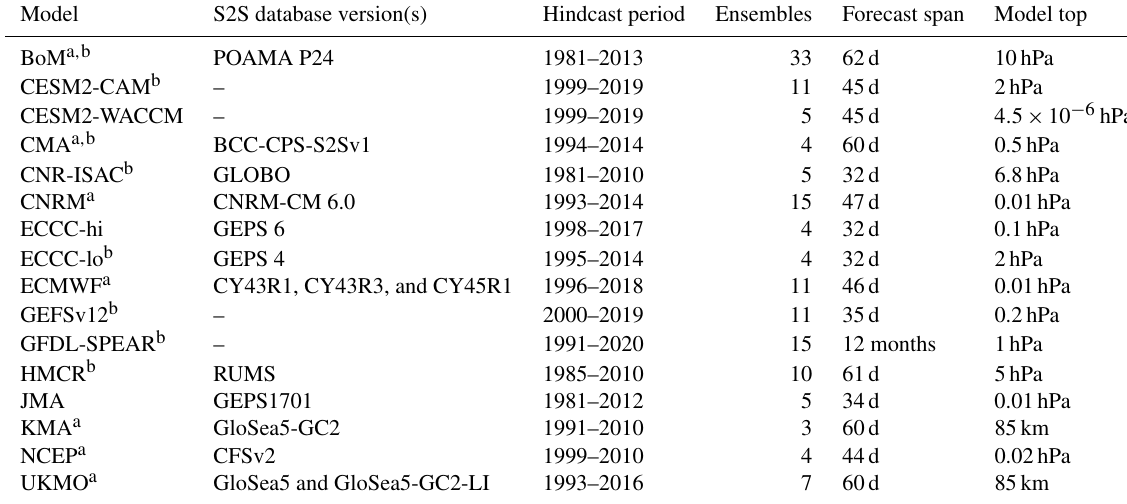
Table 1. Details of the subseasonal-to-seasonal forecast systems used herein.